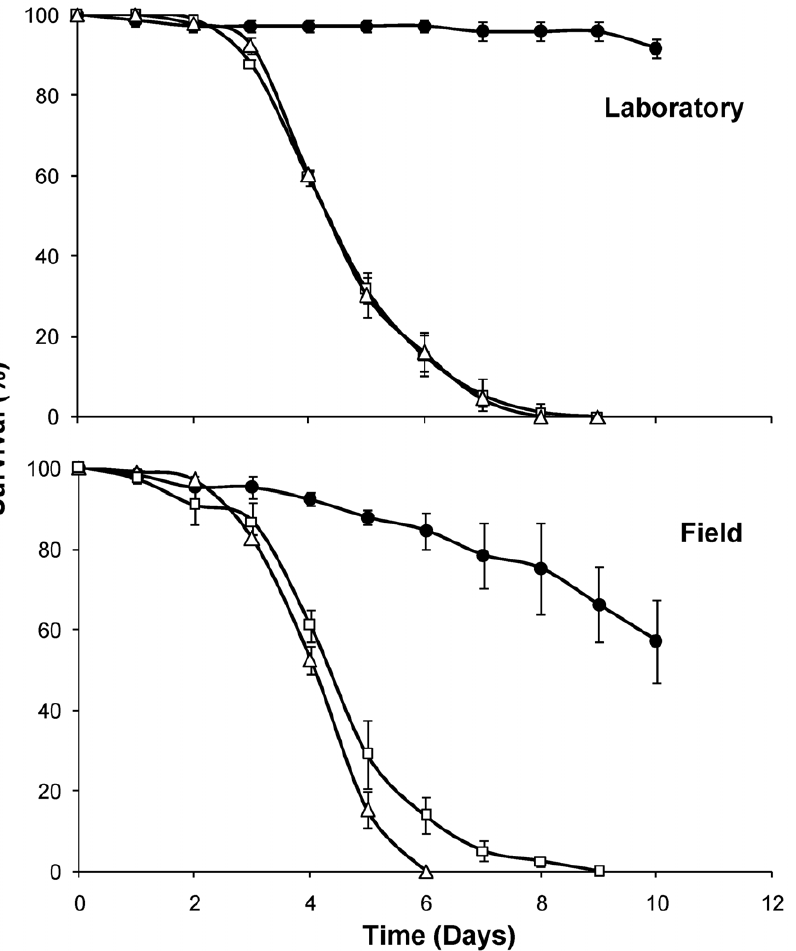
Figure 1. Effect of fungal infection on mosquito survival. Mean ( 6 SEM) cumulative proportional survival of B. bassiana -infected (triangles), M. anisopliae -infected (squares) and uninfected control mosquitoes (black circles), of the laboratory-reared (top) and field-collected (bottom) insecticide- resistant An. gambiae s.s. mosquitoes. Data represent four and three replicates, respectively, of approximately 30 females.